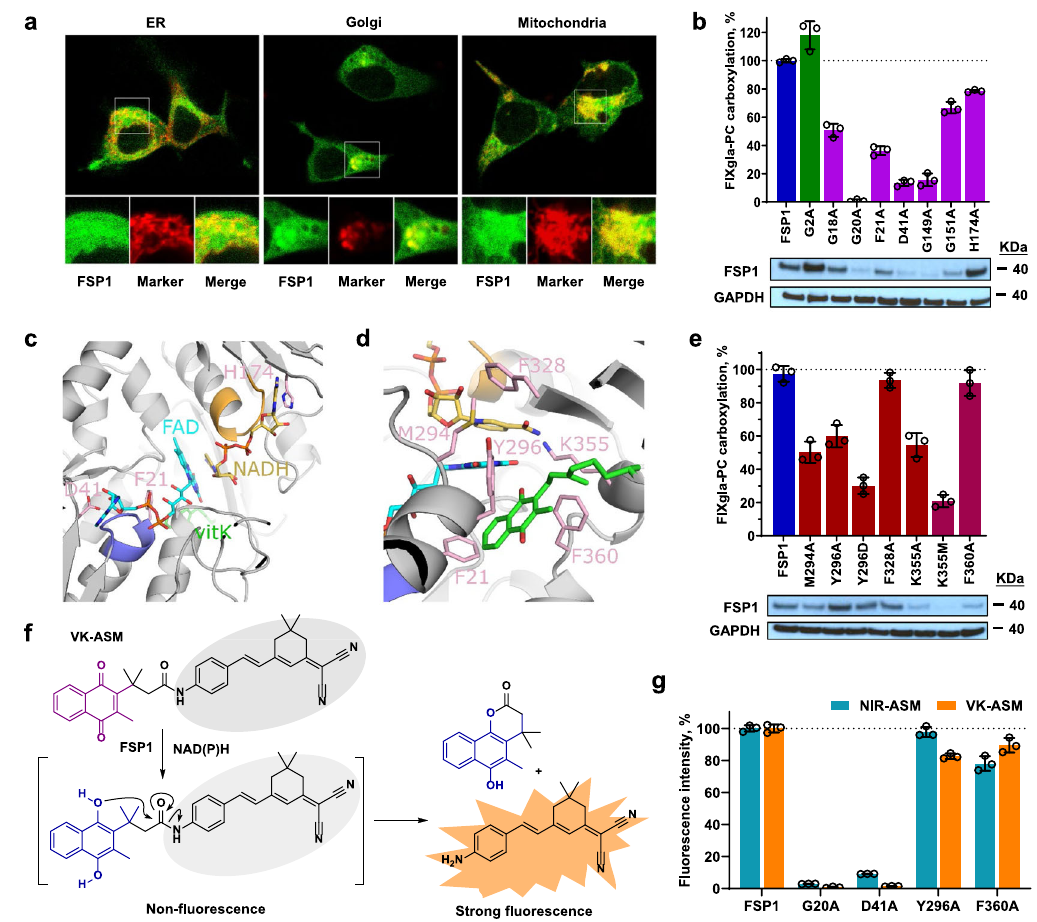
Fig. 4 | Localization and characterization of FSP1 as vitamin K reductase. a FluorescenceconfocalmicroscopeimagingofFSP1-sfGFPfusion(green)withcell organelle markers (red) of ER, mitochondrion, and Golgi. FSP1-sfGFP and the cell organelle marker were transiently co-transfected into HEK293 cells for 48h. b Effect of FSP1 myristylation site mutation (G2A) and mutations of residue responsible for the dinucleotides (NDAH and FAD) binding on VKR activity. Wild- type FSP1 or its mutants was transiently expressed in TKO cells for VKR activity assay. Wild-type FSP1 activity was normalized to 100% (indicated by dotted line). Bottom: Immunoblotting of FSP1, its mutants, and GAPDH (loading control) in the corresponding cells. c AlphaFold model of FSP1 (gray) with FAD (cyan), NADH (gold) and vitamin K (green) based on ligand positions in the yeast NDH-2 enzyme Ndi1 (PDBcode 4G73). The GxGxxG motifs are colored purple (Gly18-Gly23) and orange(Gly149-Gly154)correspondingtointeractionswiththenucleotidemotifsof FAD and NADH respectively. Residues Asp41 and His174 located near the ribose hydroxyls from the two nucleotides are colored pink as is Phe21 from the fi rst GxGxxG region. d FSP1 residues surrounding the isoalloxazine of